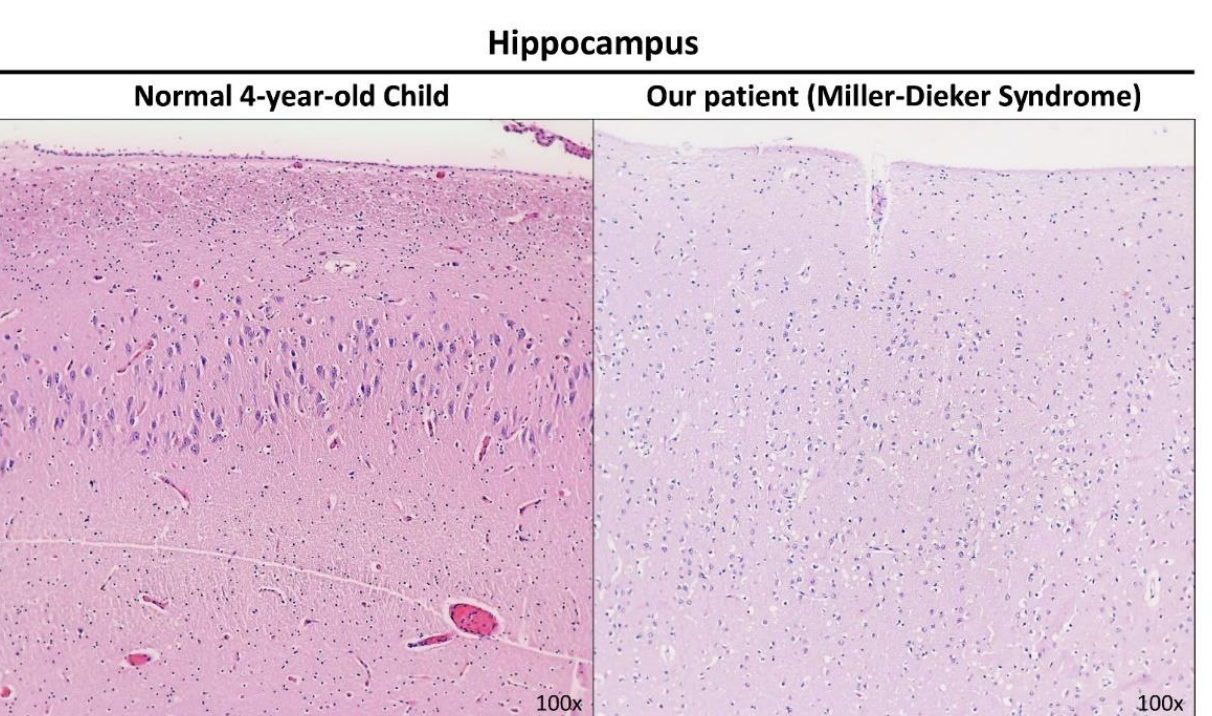
Figure 8. Microscopic images of the basal ganglia. Section of the basal ganglia stained with H&E showed extensive diffuse vacuolation of the white matter within the internal capsule ( Left panel ) compared to a normal 4-year- old child’s basal ganglia ( Right panel ). A Luxol Fast Blue (LFB) stain for myelin is accentuated in the vacuolated areas of the gray and white matter portions ( Right panel ) (200x magnification). A Luxol Fast Blue (LFB) stain for myelin was performed to reveal that in the cerebral cortex, there was myelin that concentrated in the third layer of the cortex with discrete axonal (linear) staining, but mostly neuropil (diffuse) staining. Within the basal ganglia,